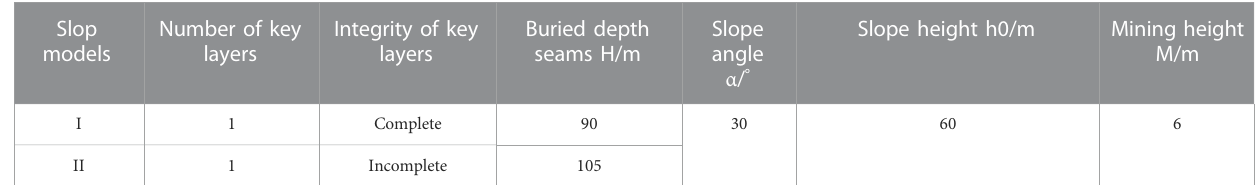
TABLE 2 Basic slope models.